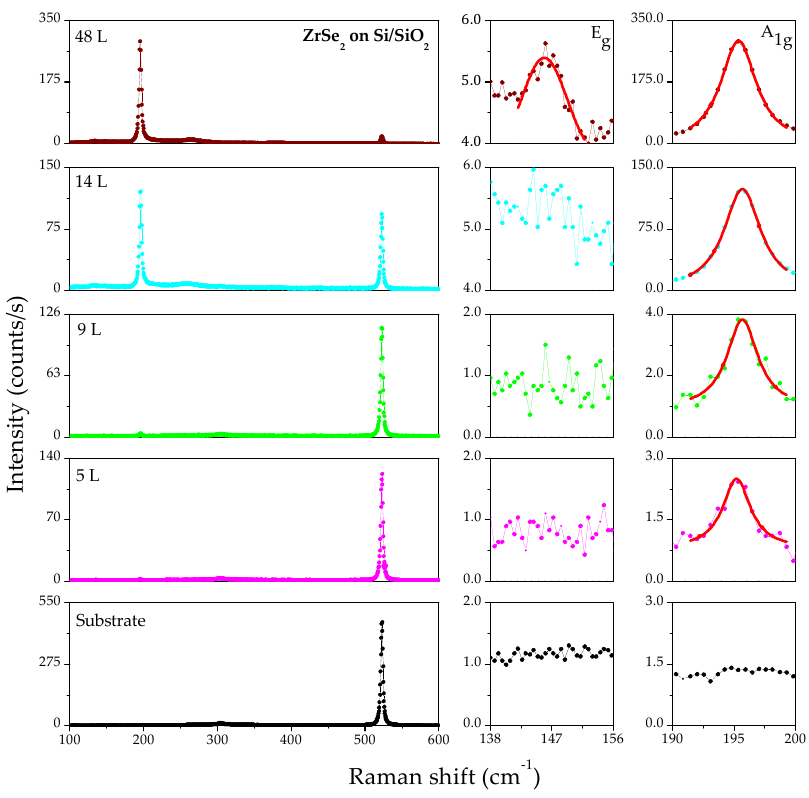
Figure C5. Thickness dependence of the Raman spectra for ZrSe 2 on a Si/SiO 2 substrate ( λ = 638 nm). Broad range spectra as well as zooms in the region of the A 1g and E g modes with their corresponding fitting are presented. Fitting results are given in Table C3.